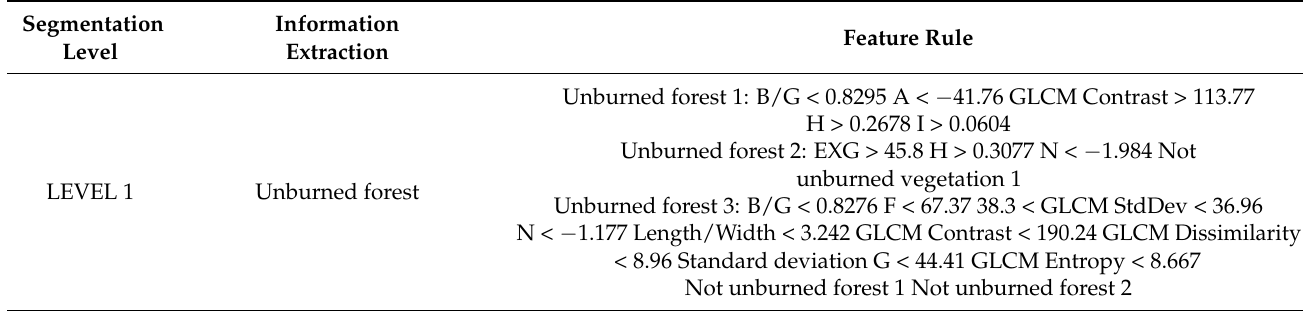
Table 3. Classification feature rules for different